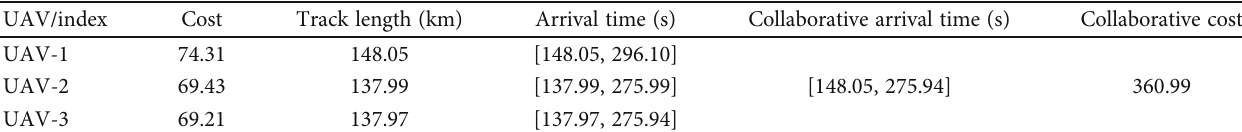
Figure 11: Collaborative track planning. Table 7: Collaborative track planning